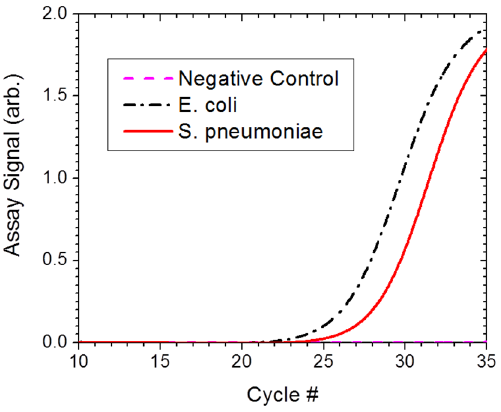
Figure 14. The real time RT-PCR results for detection of a variety of Gram-negative and Gram-positive bacterial species. Electrical lysis was demonstrated for a variety of Gram-negative and Gram-positive bacterial species using an E-Lysis chamber with combined electric field and flash heating to 100 u C. This was demonstrated by performing real time RT-PCR assays directly on the lysate. Each data point represents 5 independent runs with two replica samples in each run.